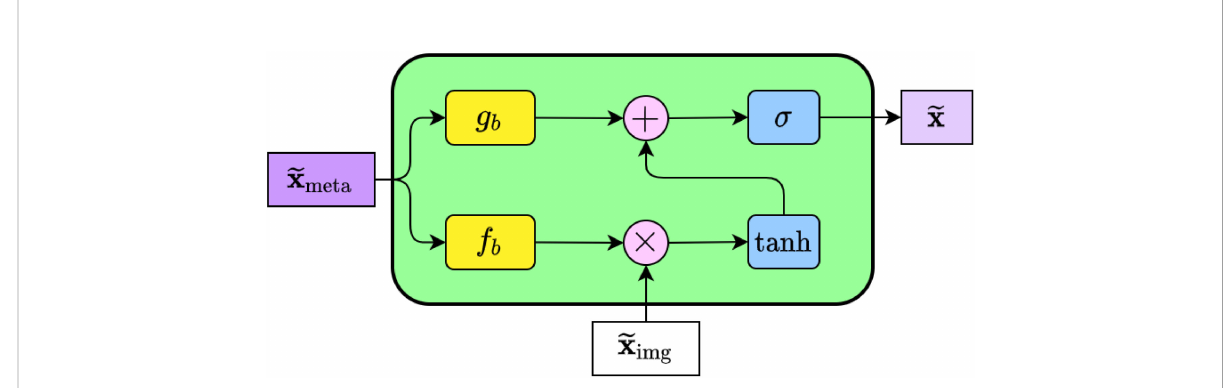
FIGURE 3 The internal structure of the MetaBlock. In summary, the block learns how to enhance the image features based on the metadata features. The output features array has the same shape as the image